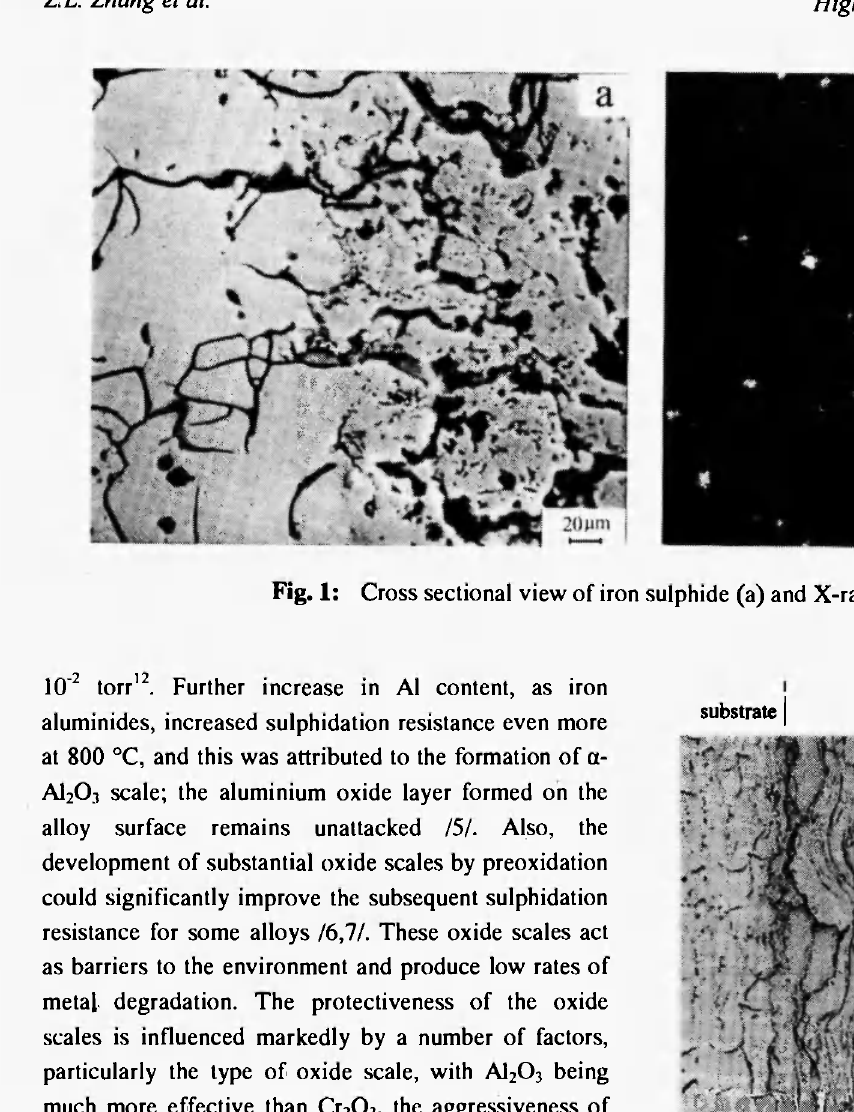
A general cross sectional view of the composite coatings after testing for 216